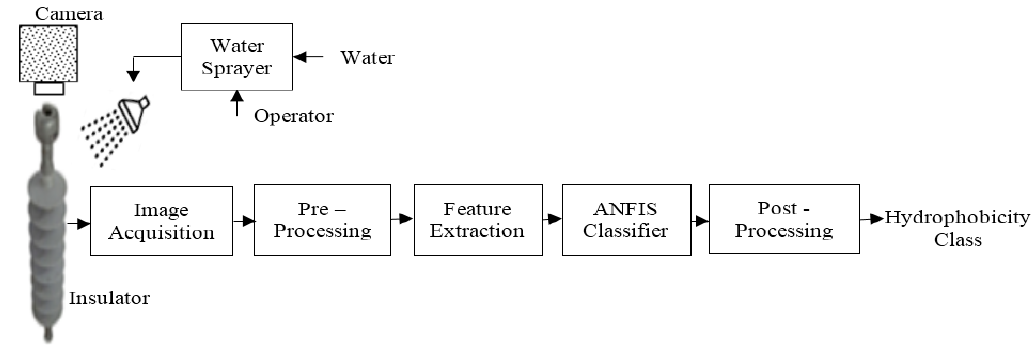
Figure 1. Proposed hydrophobicity classifier.